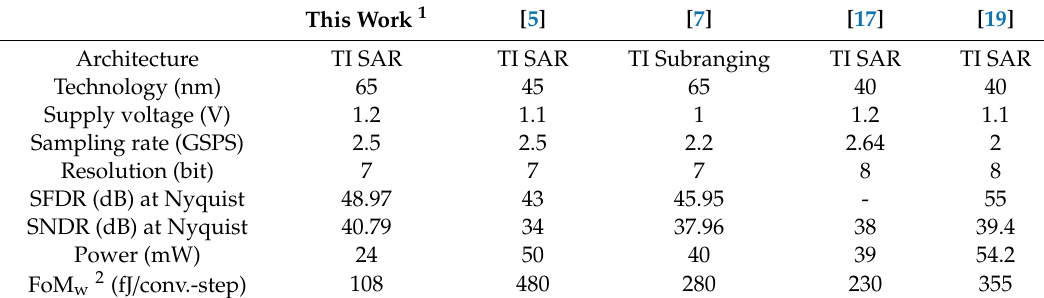
Table 2. Performance